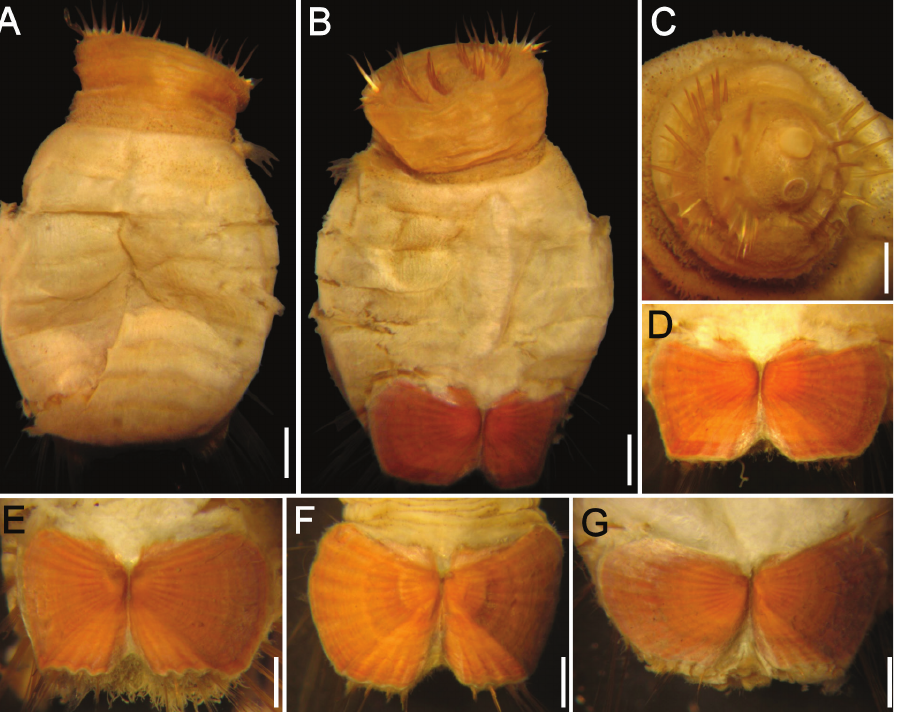
Figure 4. Sternaspis annenkovae sp. n. A Holotype (ZIRAS 50602 ) , dorsal view B Same, ventral view C Same, ventro-caudal shield D Paratype, anterior end, oblique frontal view E – G Ventro-caudal shields of three paratypes. Bars: A, B 1.3 mm, C, G 1.1 mm, D 0.7 mm, E 0.8 mm, F 1